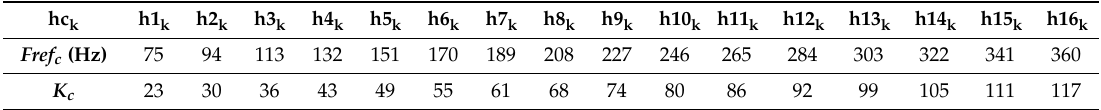
Table 2. Summary of the reference filters bank parameters.